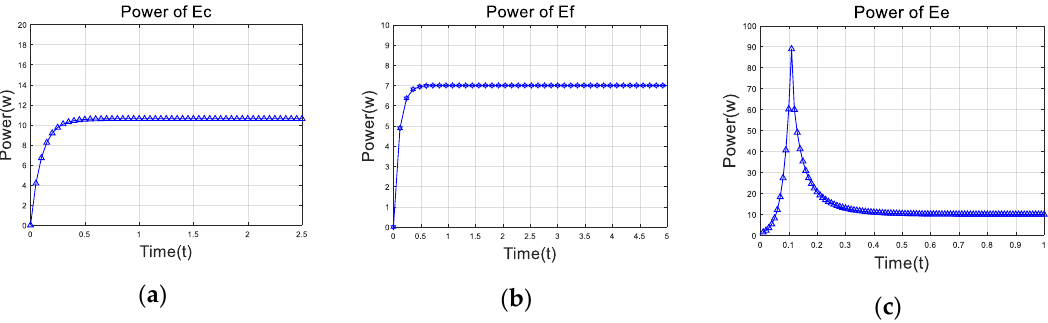
Figure 5. Ec, Ef, and Ee change versus time. ( a ) Ec changes versus time, ( b ) Ef changes versus time, ( c ) Ee changes versus time.